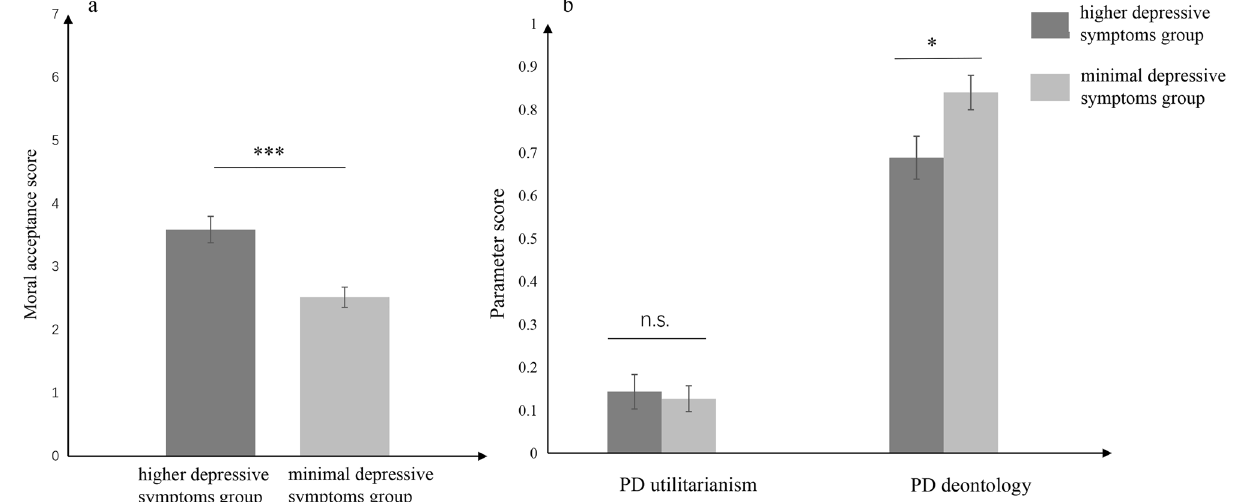
Figure 1. ( a ) The moral acceptance score for the higher depressive symptoms group/minimal depressive symptoms group. ( b ) Mean standardized parameter U and parameter D for the individuals with depression and healthy controls. Error bars indicated standard errors. * p < 0.05, *** p < 0.05, and n.s. indicated no-significant differences as p >